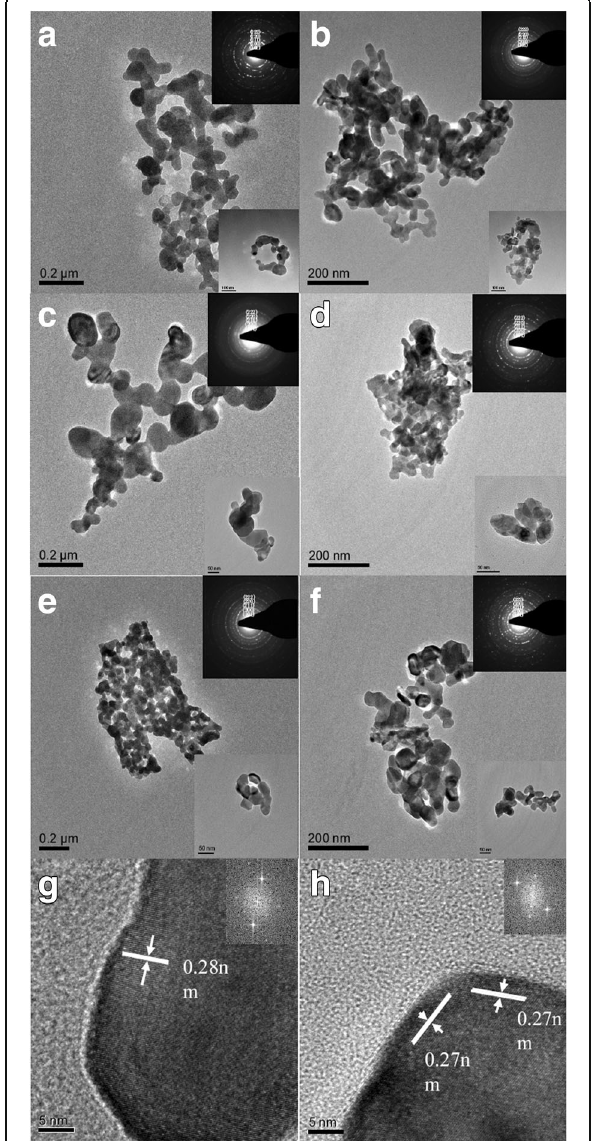
Fig. 4 TEM images of the (La 1 − x Pr x ) 0.67 Ca 0.33 MnO 3 nanoparticles 2 /D 12 ratios of the polycrystalline spots. Based on their D i post-annealed at 800 °C with different Pr-doping concentrations. a x =0.0, b x =0.1, c x = 0.2, d x = 0.3, e x = 0.4, and f x = 0.5. Insets in ( a – f ) indexed as (101) , (200) , (211) , (220) , and (222) , are the corresponding SAED patterns of the (La 1 − x Pr x ) 0.67 Ca 0.33 MnO 3 pc pc pc pc pc nanoparticles, respectively. The indices are labeled based on the pseudo-cubic perovskite structure. g – h HRTEM images of the from single (La Pr ) Ca MnO nanoparticle 1 − x x 0.67 0.33 3 (La 1 − x Pr x ) 0.67 Ca 0.33 MnO 3 nanoparticles with Pr-doping concentration with x = 0.1 and 0.3, respectively. The lattice fringes x =0.1 and x =0.3. Insets are the FFT patterns of the HRTEM